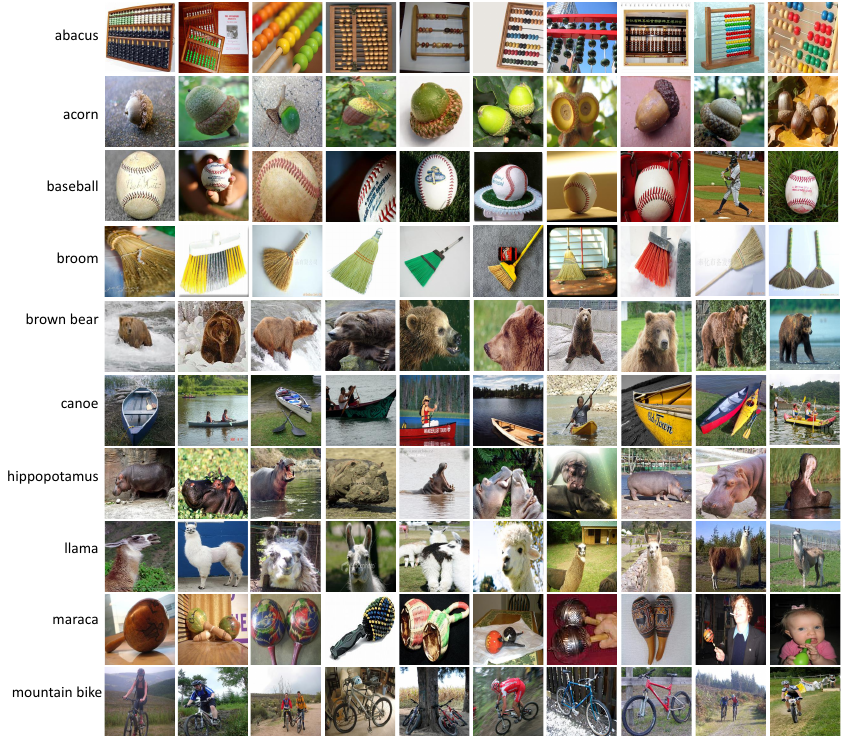
Figure A1. The 100 ancestor images A p q used in the experiments. A p q pictured in the q th row and q th column (1 ≤ p , q ≤ 10) is randomly chosen from the ImageNet validation set of the ancestor category c a specified on the left of the q th q